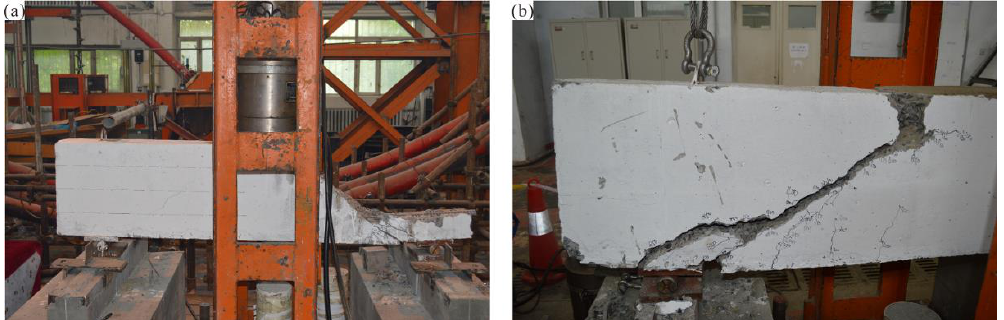
Figure 5. Failure mode and crack distribution of RC-con beam.